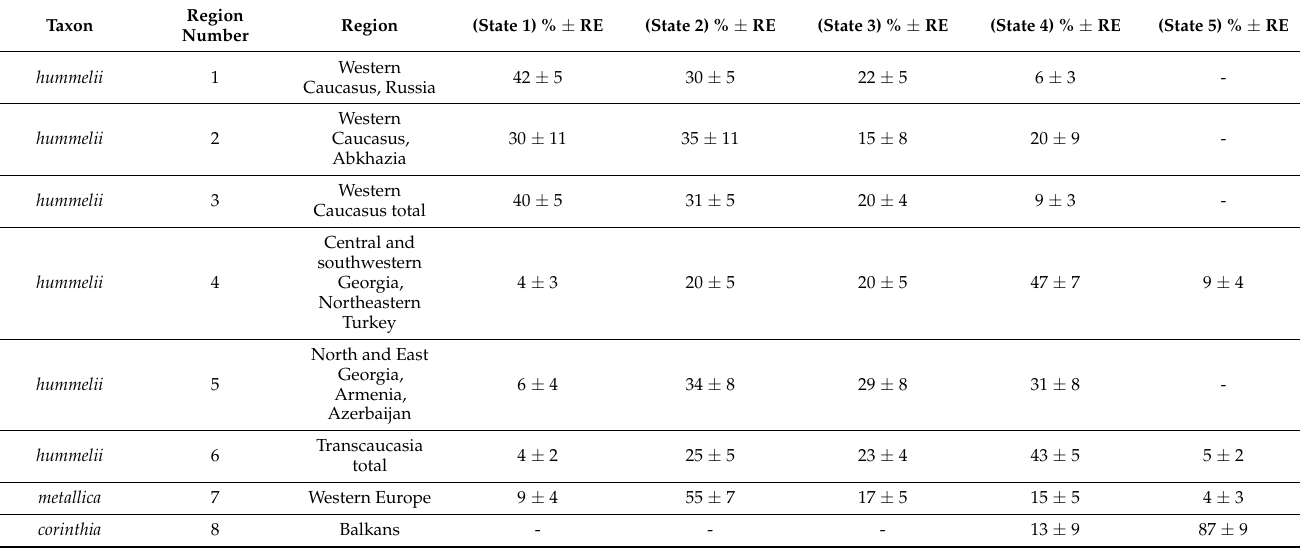
Table 11. Punctures at the elytral disk. RE—share representativeness